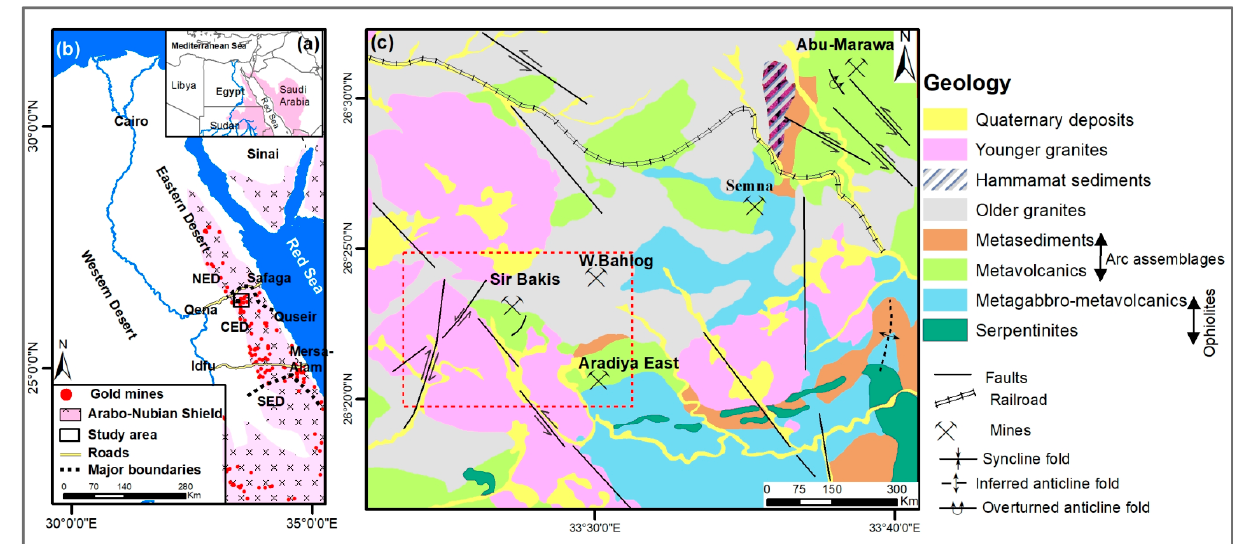
Figure 1. Location map ( a ) Regional geologic map of the ANS in Egypt showing the distribution of gold mines as solid red circles, ( b ) gold mines at the Eastern desert of Egypt overlain the ANS. The study area appears in black rectangle, ( c ) Geological map of the area outlined in black in ( a ) from [30]. The location of the study area is indicated by a dashed red rectangle.